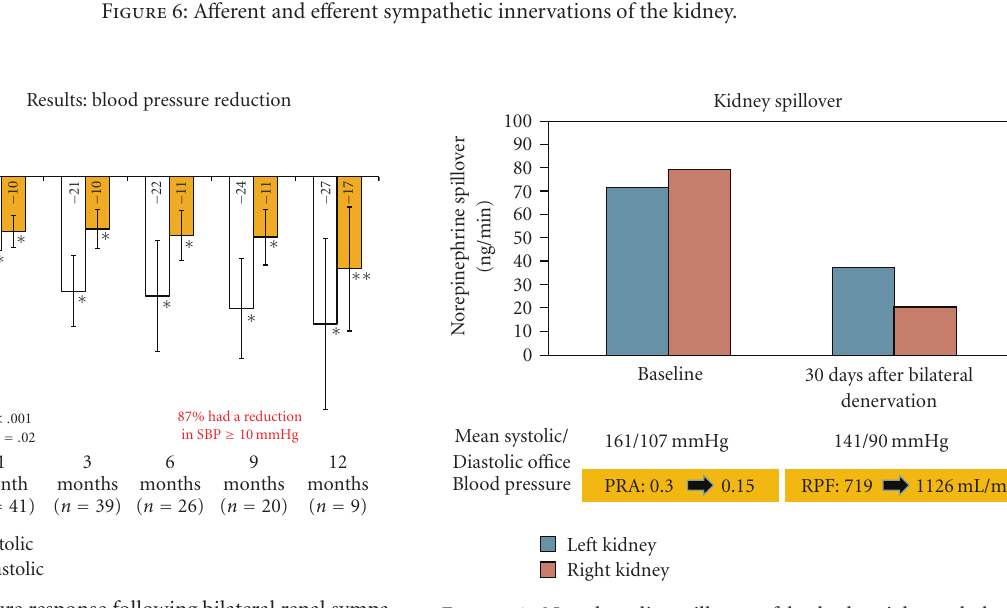
Figure 8: Noradrenalin spillover of both the right and the left kidneys at baseline and 30 days after sympathetic renal